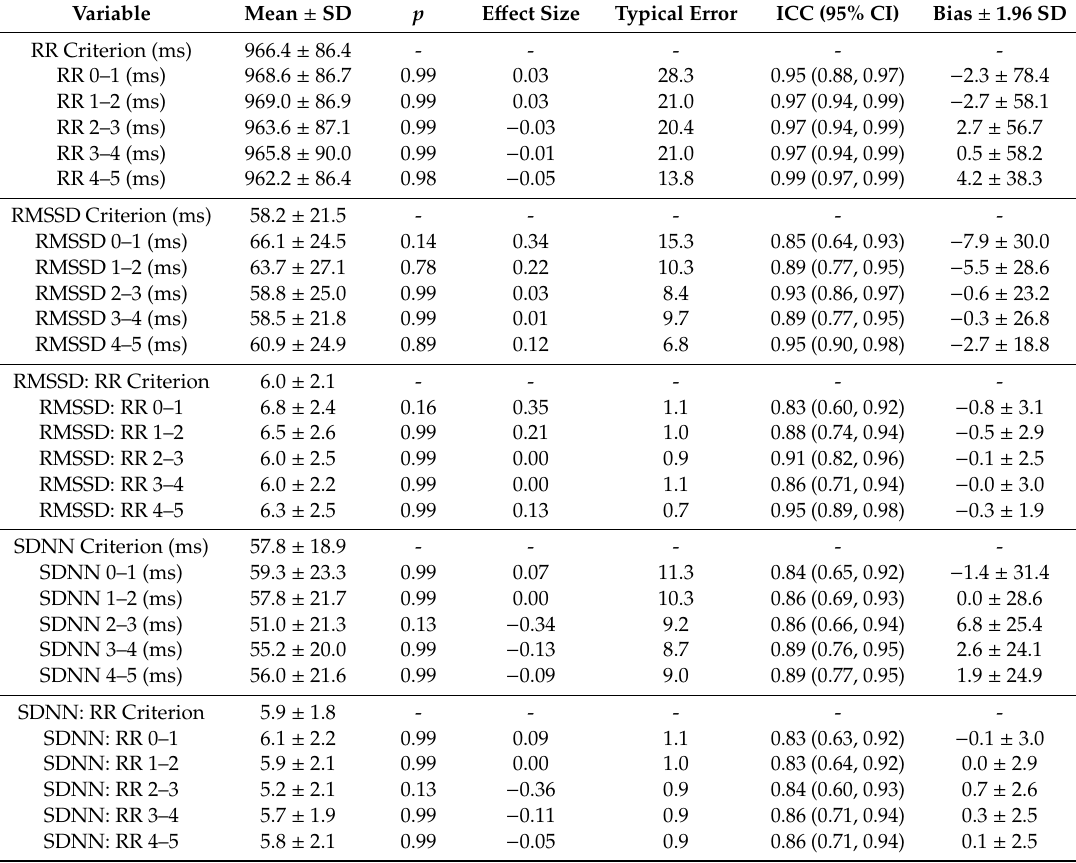
Table 1. Comparison values and statistics between criterion and 1-min